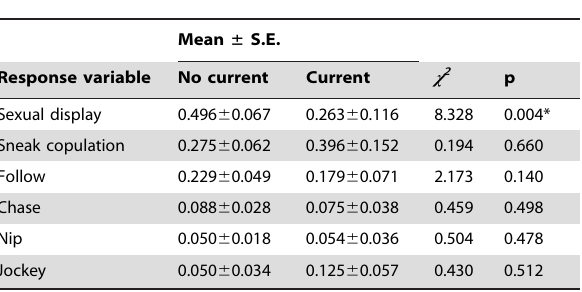
Table 1. The effect of treatment on the number of male reproductive behaviors. Mean behaviors are reported per male per minute.